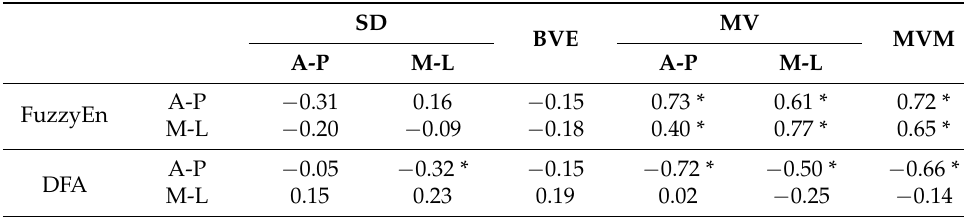
Table 1. Correlation analysis between non-linear tools and traditional variables in the leg with better balance (lower EBV) (this analysis included BMX athletes and controls; n = 39). SD MV BVE MVM A-P M-L A-P M-L A-P − 0.31 0.16 − 0.15 0.73 * 0.61 * 0.72 * FuzzyEn M-L − 0.20 − 0.09 − 0.18 0.40 * 0.77 * 0.65 * A-P − 0.05 − 0.32 * DFA